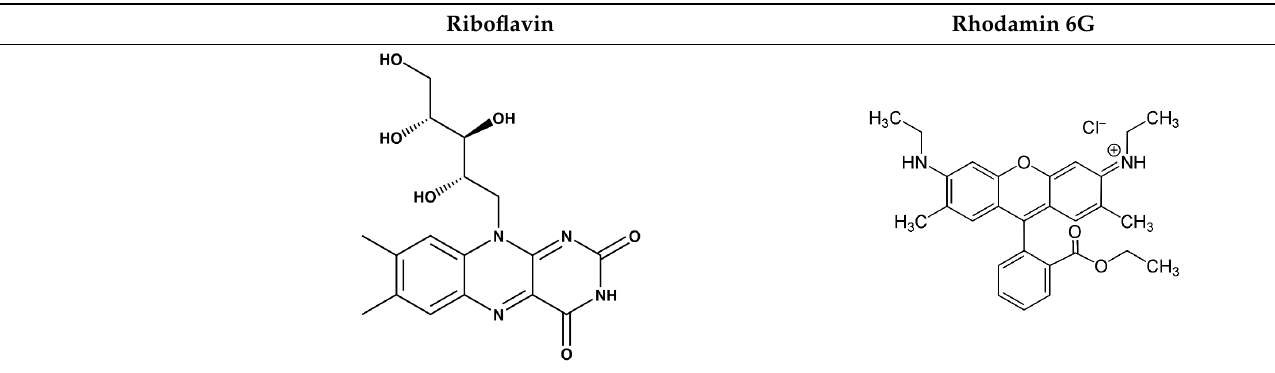
Table 2. Raman measurement parameters for riboflavin and rhodamine 6G.